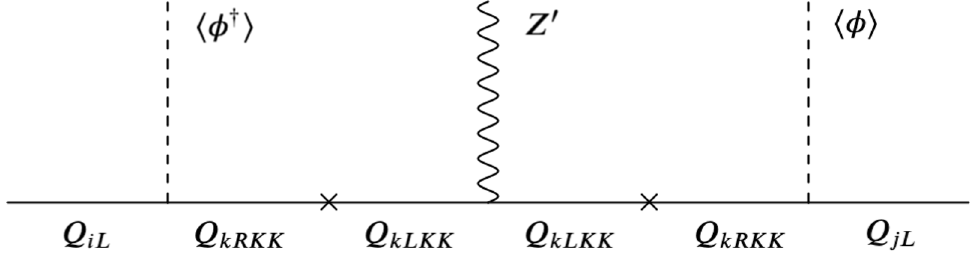
Figure 4 . Diagrams for the effective Z 0 coupling to the isoneutral quark doublets Q iL , mediated by the isocharged KK excitations (where Z 0 only couples to isocharged states). Similar diagrams may be drawn for all the SM fermions Q iL , u iR , d iR , L iL , e iR , which are isoneutral, with effective Z 0 couplings mediated by their respective isocharged KK